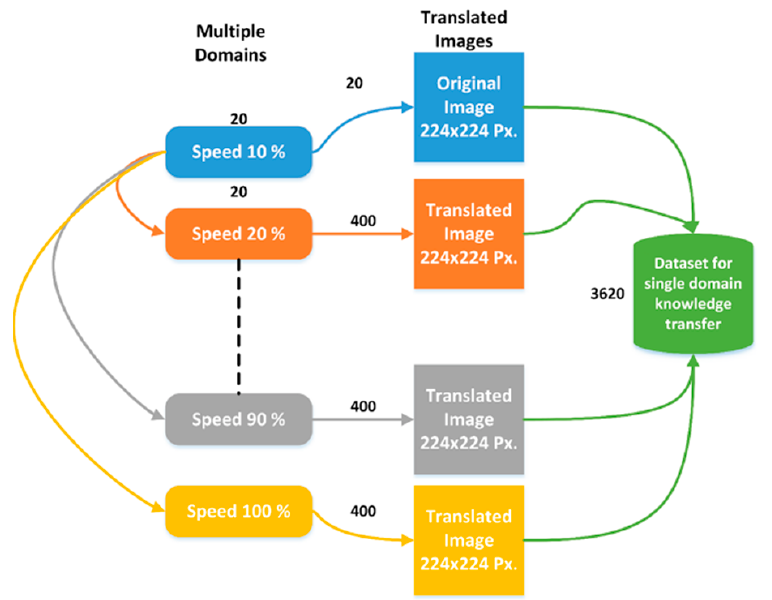
Figure 18. Details of domain knowledge transfer and data generation for a single domain of 10% speed.